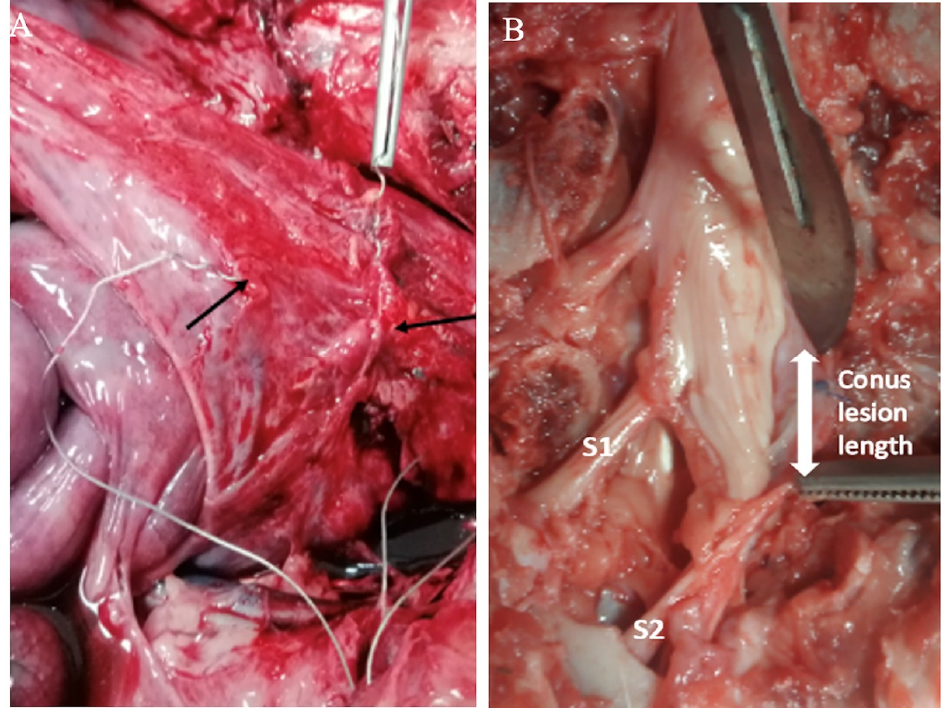
Figure 5. Autopsy photographs of bladder wall electrodes and the sacral cord lesion. ( A ) The leads of two helical-wire hook electrodes are shown where they had been implanted on the right side of the bladder wall (black arrows); a forceps is attached to one electrode lead. Looping of the four electrode leads in the suprapubic area is also shown. ( B ) Sacral spine showing S 1 and S 2 levels of the lesion. The lower sacral levels, S 3 , S 4 , S 5 , were partially